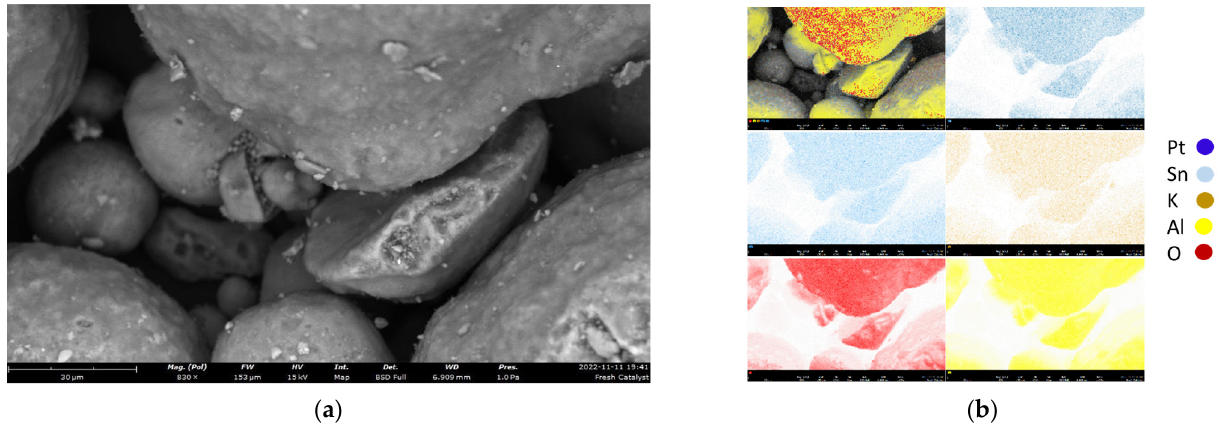
Figure A3. TPR signal obtained via TPR analysis of the fresh Pt-Sn-K/Al 2 O 3 catalyst used in this work. The crystalline structure of both the Pt-Sn-K/γ-Al 2 O 3 and the γ-Al 2 O 3 support was analyzed via XRD spectra, which are depicted in Figure A4.